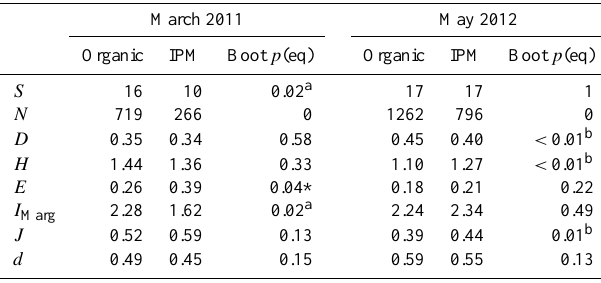
Table 4. Taxa richness ( S ), abundance ( N ), and biodiversity index values ( D : dominance; H : Shannon–Wiener; E : Buzas and Gib- son’s evenness; I Marg : Margalef; J : equitability; d : Berger–Parker) for each management type in spring and autumn